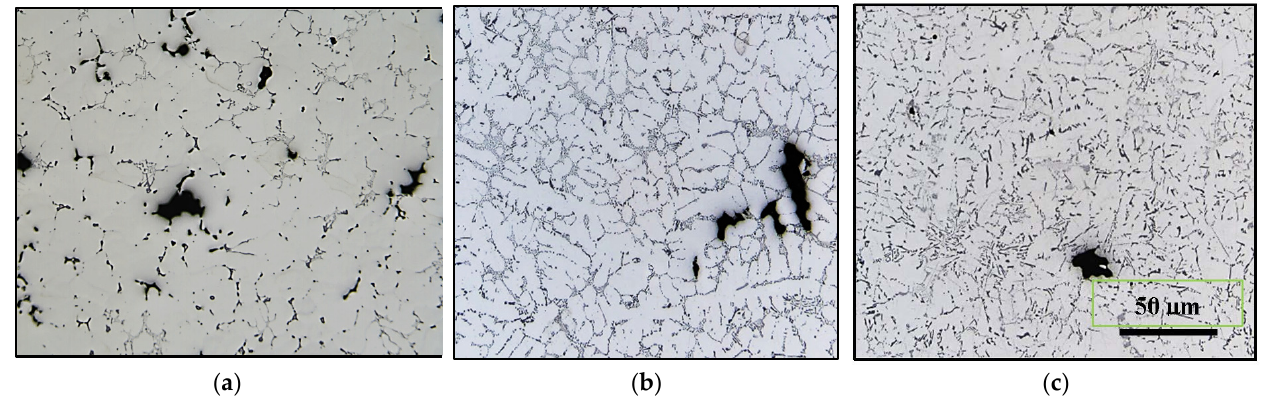
Figure 8. Variation in shrinkage porosity as a function of Si content: ( a ) 0.5% (220 alloy), ( b ) 8.5% (380 alloy), and ( c ) 11.5% (413 alloy).